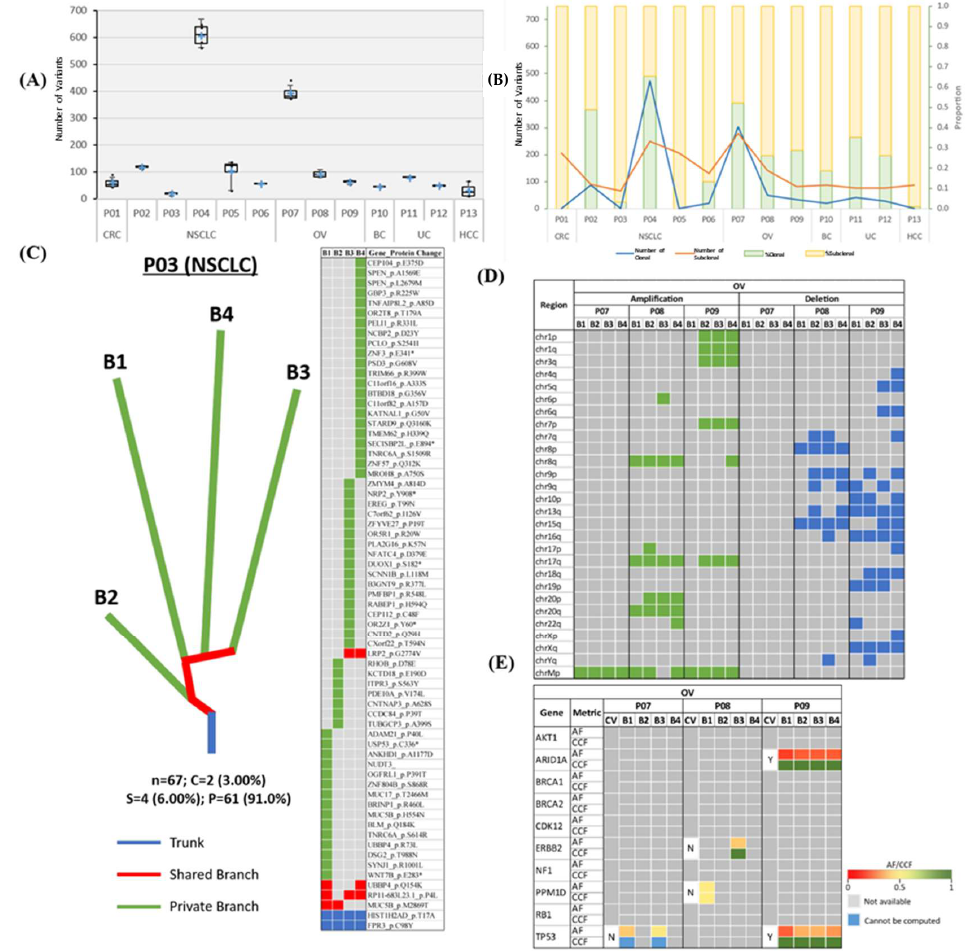
Figure 2. Mutational landscape of patients across six cancer types. ( A ) Boxplot illustrating nssML. A cross ( + ) represents the mean value of the data. ( B ) Line chart and stacked bar chart representing the number and proportion of truncal / branch variants, respectively. ( C ) Representative phylogenetic tree and mutation heatmap for patient P03. Trunk, branch and private branches of the tree signify mutations that occur in all, in some but not all, and only one MRTB sample(s) resected from the patient, respectively. Heatmap demonstrates the presence (green: private; red: branch; blue: trunk) or absence (gray) of NSS mutations in each MRTB sample. Bx denotes an MRTB sample with identification number x. The total number of NSS, truncal (percentage), branch (percentage), and private (percentage) mutations are denoted by ‘n’, ‘C’, ‘S’, and ‘P’, respectively. ( D ) Heatmap illustrating the presence and absence (gray) of CNAs for patients with OV. Large-scale amplifications and deletions are represented with areas filled with green and blue, respectively. ( E ) ssCDMs for OC and their associated AF and CCF. CV: clonal (truncal) variant; Y: yes; N: no; AF: allele frequency; CCF: cancer cell